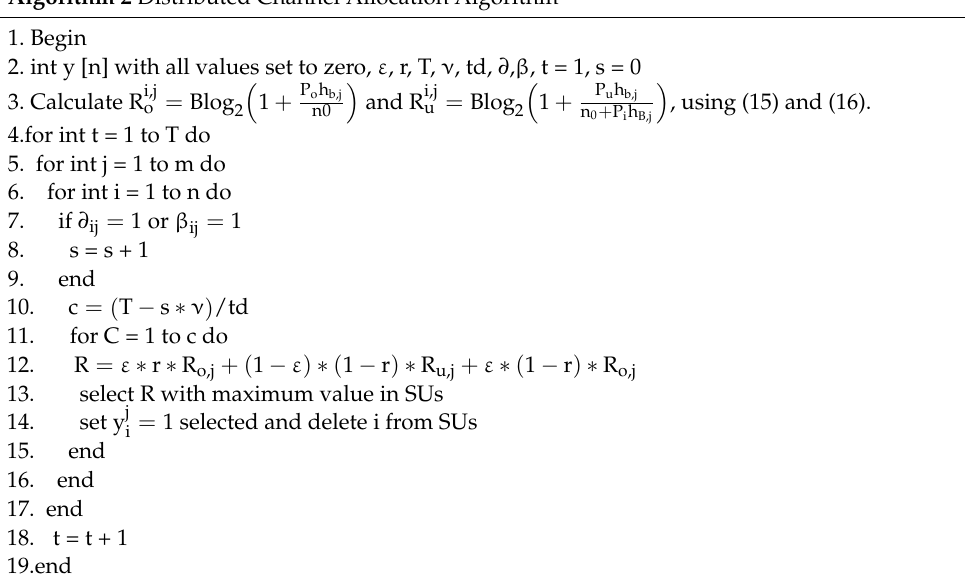
Algorithm 2 Distributed Channel Allocation